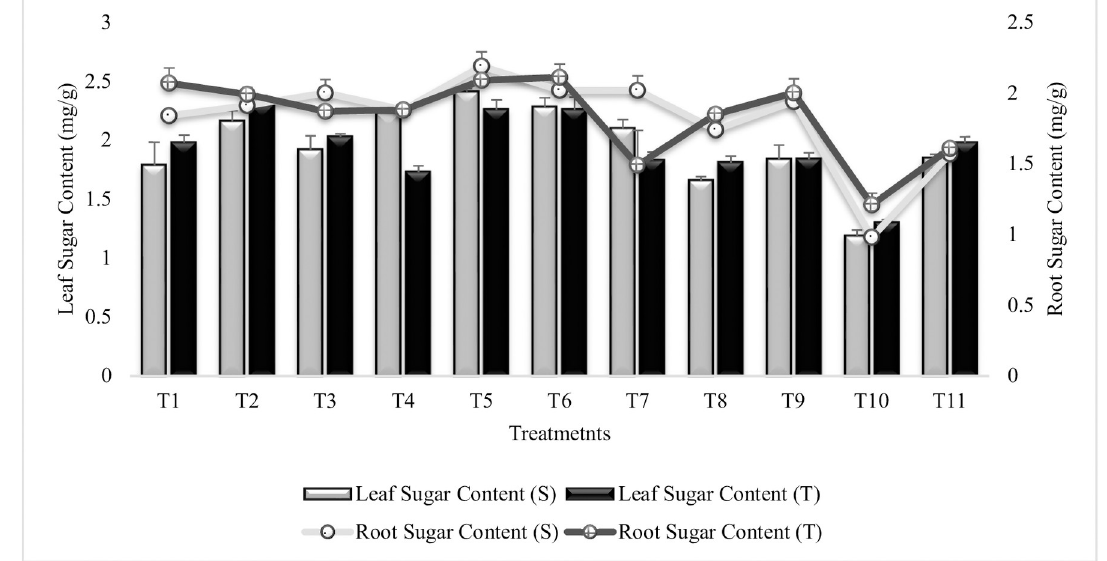
Fig 4. Leaf and root sugar contents of chickpea grown in sandy soil. Data are means of four replicates along with standard error bars (S-Sensitive Variety; T-Tolerant Variety).